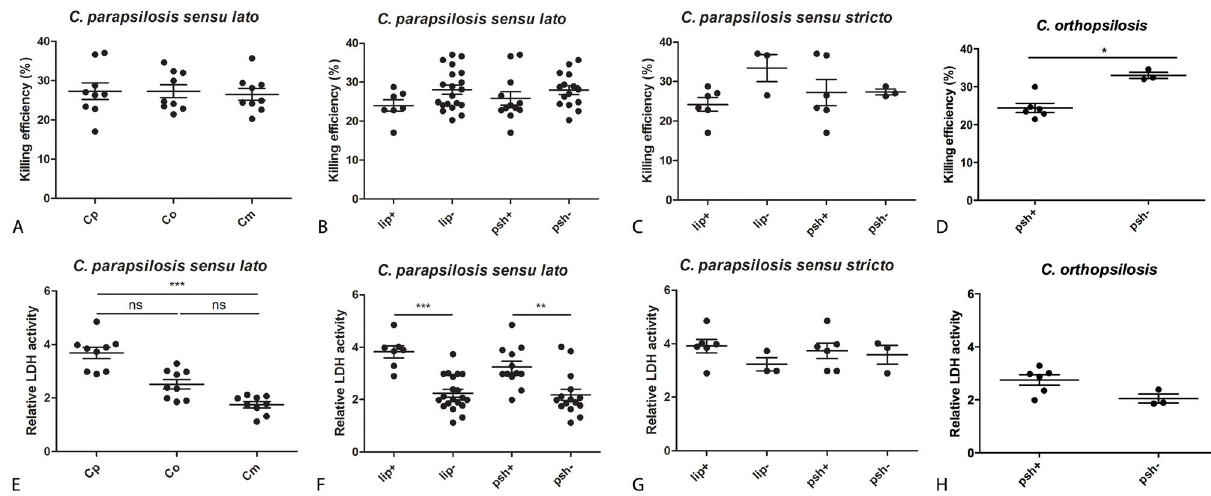
Figure 2. Interactions of C. parapsilosis sensu lato isolates (see Table S1.) with J774.2 murine macrophages. (A) Killing efficiency of C. parapsilosis sensu lato species determined by CFU determinations (Cp, C. parapsilosis sensu stricto ; Co, C. orthopsilosis ; Cm, C. metapsilosis ), (B) killing efficiency of lipase producer vs. non-producer and pseudohypha positive vs. negative strains in the C. parapsilosis sensu lato group [lip+, lipase positive (regardless of pseudohypha production); lip-, lipase negative; psh +, pseudohyphae positive (regardless of lipase production); psh-, pseudohyphae negative], (C) killing efficiency of lipase or pseudohypha positive vs. negative isolates of C. parapsilosis sensu stricto , (D) killing efficiency of lipase or pseudohypha producer vs. non-producer strains of C. orthopsilosis , (E) host-cell damaging capacity of C. parapsilosis sensu lato species based on the release of LDH (lactate dehydrogenase), (F) host-cell damaging capacity of lipase or pseudohypha producer vs. non-producer strains in the C. parapsilosis sensu lato group, (G) host-cell damaging capacity of lipase or pseudohypha positive vs. negative isolates of C. parapsilosis sensu stricto , (H) host-cell damaging capacity of lipase or pseudohypha producer vs. non-producer strains of C. orthopsilosis , C.p., C. parapsilosis sensu stricto ; C.o., C. orthopsilosis ; C.m., C. metapsilosis ; cont, control (macrophages without fungal cells). Data points on graphs represent individual strains. Experiments were performed in triplicates. Data were analyzed by the Kruskal-Wallis test (A, E) or the Mann-Whitney test (B, C, D, F, G, H). * p<0.05, ** p<0.01, *** p<0.001. doi: